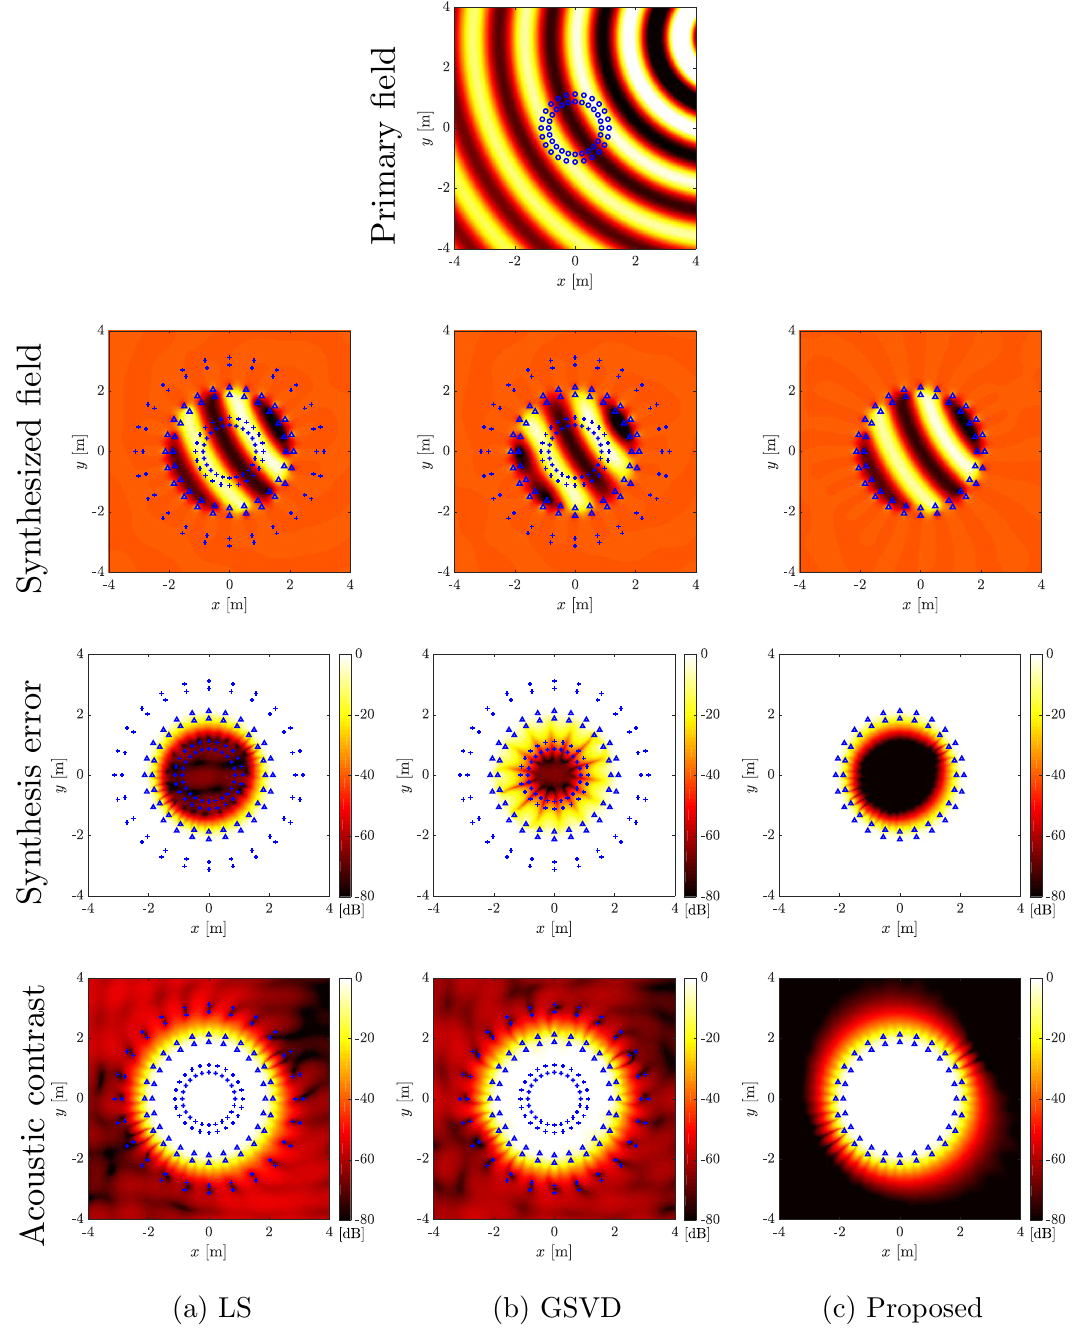
Figure 7. Results of primary sound field, synthesized sound field, interior sound field synthesis accuracy and exterior acoustic contrast by LS, GSDV, and proposed mode-matching methods with ∆ = 0.25 m in reverberant condition for f = 200 Hz. Blue ◦ , (cid:52) and + are microphones, loudspeakers and control points,